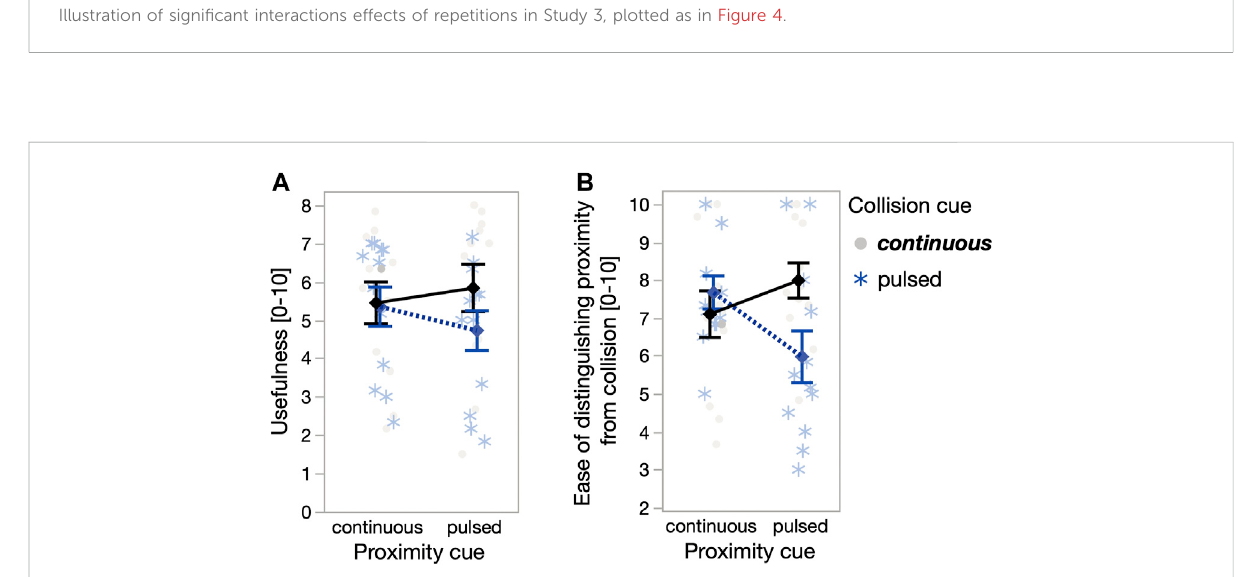
FIGURE 7 Illustration of signi fi cant interaction effects of proximity and collision cues on usefulness ratings (A) and distinguishability (B) of Study 3, plotted as in Figure